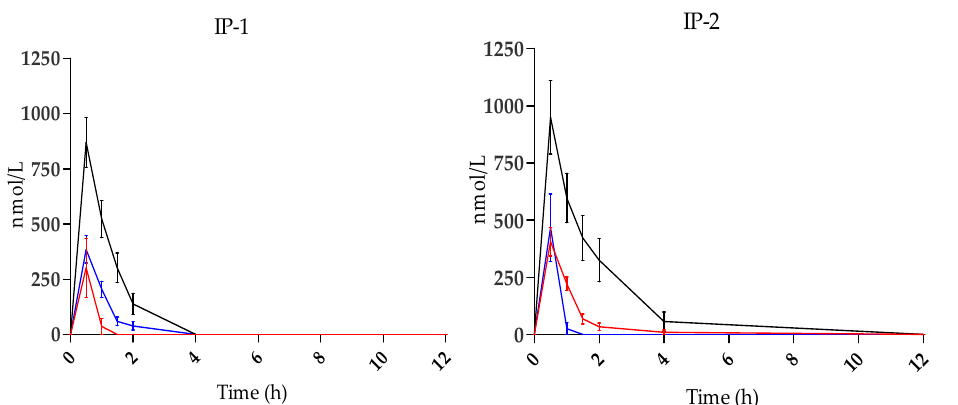
Figure 1. Mean plasma concentration profile of main HT metabolites before (0 h) and after intake of IP-1 ( n = 12) and IP-2 ( n = 13). HVA: black lines; HT-3-S: blue lines; DOPAC: red lines. Bars: SEM.